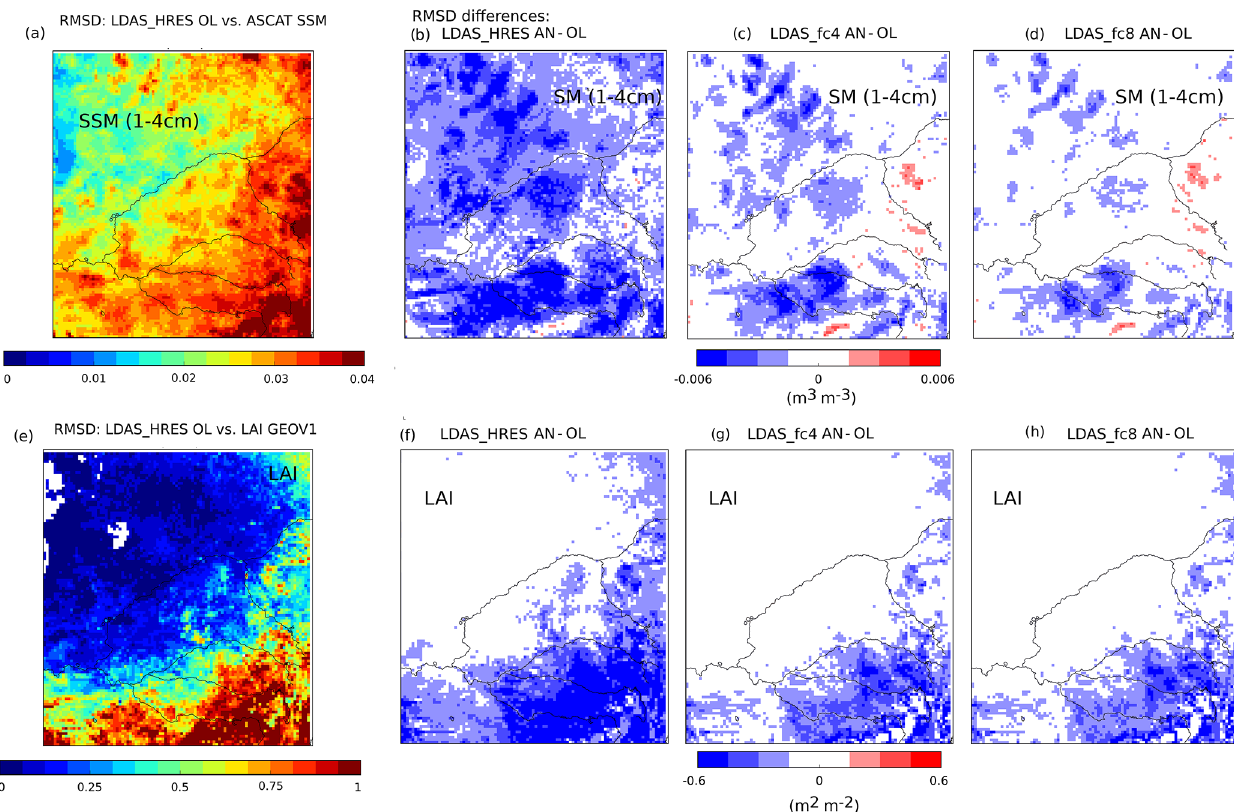
Figure 15. Same as Fig. 14 for the Murray–Darling River (MUDA) area in south-eastern Australia.